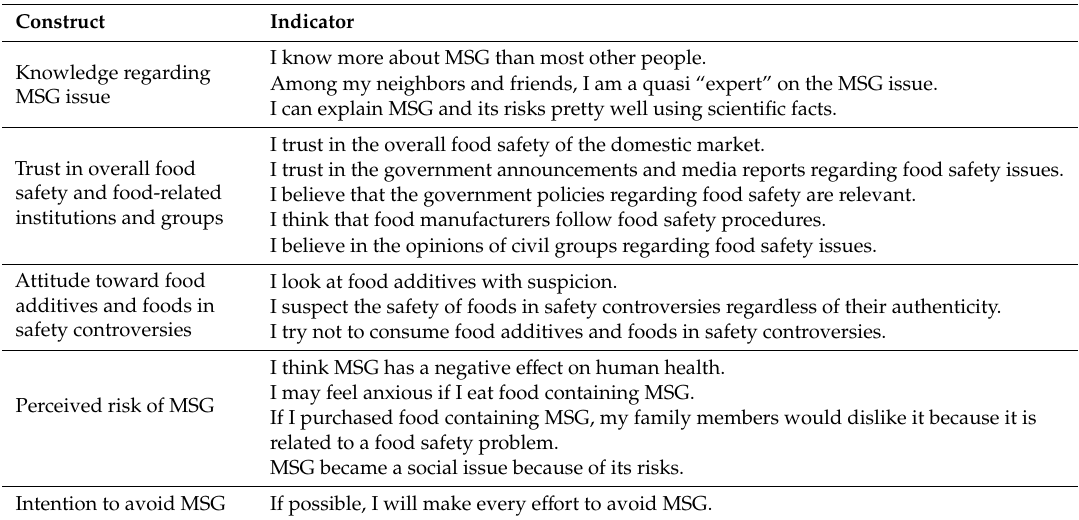
Table 3. List of indicators used to measure each